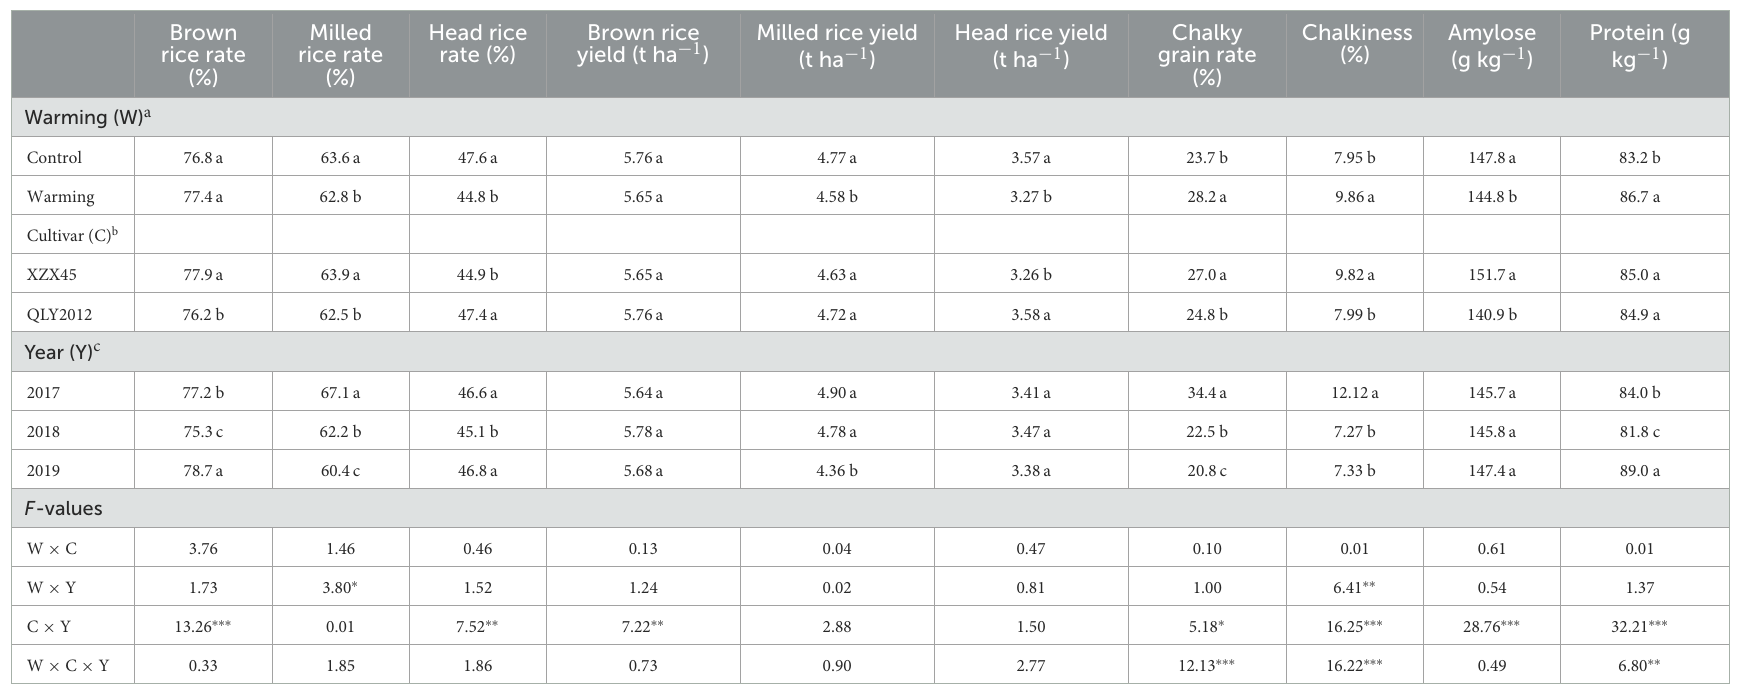
TABLE 3 Rice grain quality as affected by warming, cultivar, and study